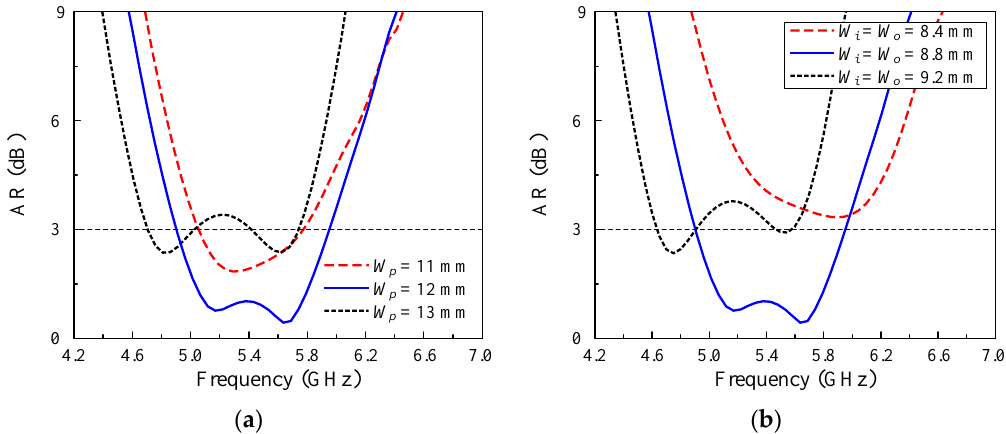
Figure 4. Simulated AR of the uniform MS-based antenna with di ff erent values of ( a ) patch size ( W p ) and ( b ) unit cell size ( W i = W o